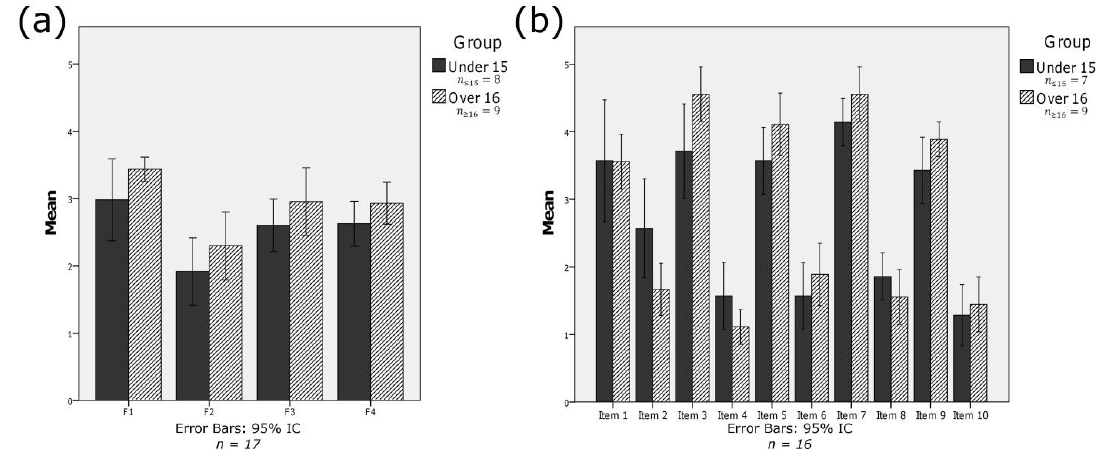
Figure 6. ( a ) TMBQ—responses; ( b ) SUS questionnaire—responses.